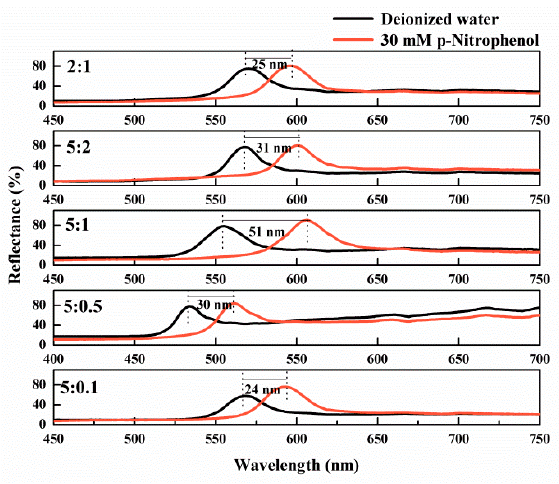
Figure 2. Optical response of IOPPCs fabricated at different ratios of monomer and crosslinker.